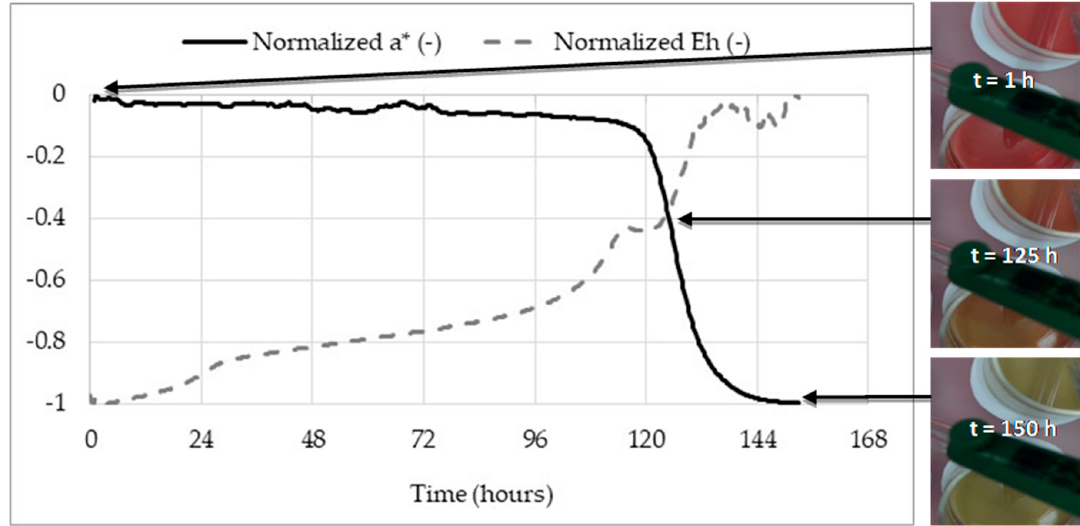
Figure 4. Monitoring of the color transfer (normalized values of a*, in black solid line) of a non-decontaminated rib steak juice (50 mL of juice diluted 1/5) at 4 °C and of the redox potential (normalized values of E h , in grey dashed line) as a function of time and associated photos showing the color transfer of non-decontaminated juices (duplicated on the right) at t = 1 h, t = 125 h, and t = 150 h.